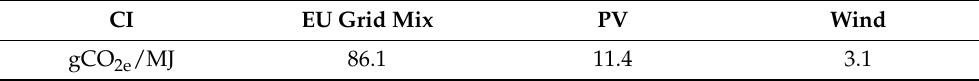
Table 2. Carbon intensity of electricity (from Scarlat et al.